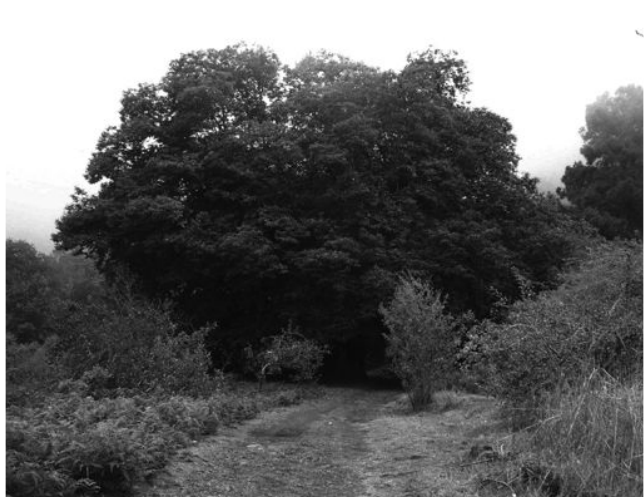
Fig. 1 - Ancient chestnut tree with 7 main branches named castaño del las 7